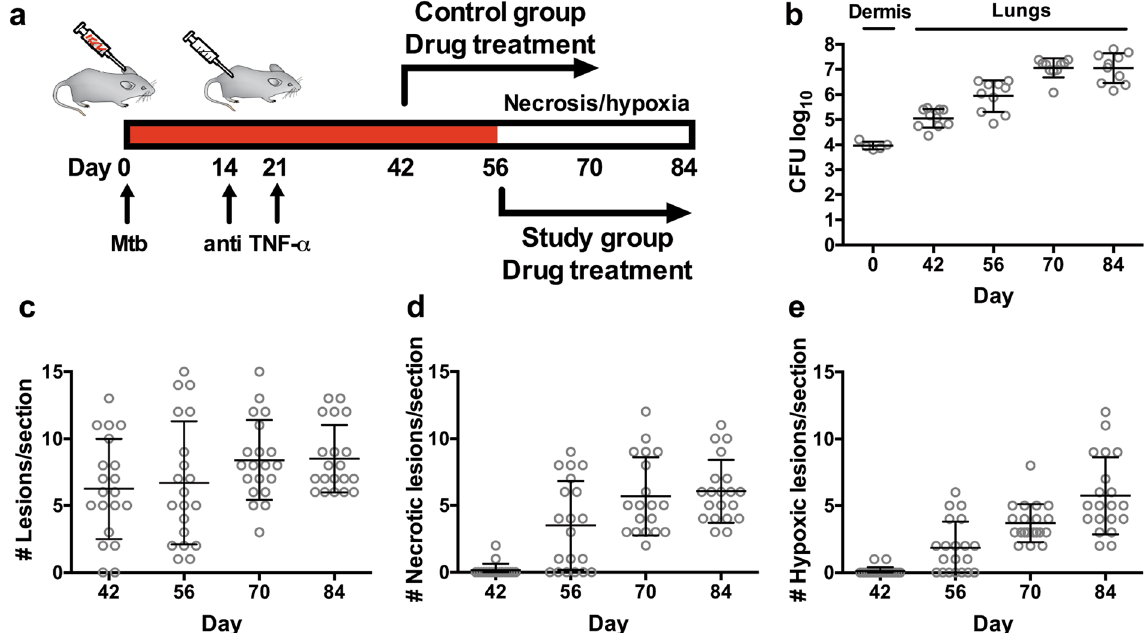
Figure 1. Temporal development of hypoxic necrotizing lung lesions in Nos2 − / − mice upon dermal M. tuberculosis infection. ( a ) Schematic representation of study design. ( b ) Infection dose (day 0) and bacterial burden in lungs at 42, 56, 70 and 84 days post-intradermal M. tuberculosis infection determined by plating serial dilutions of lung homogenates on agar. n = 10, representative of 2 independent experiments. ( c – e ) Histopathological evaluation of sections obtained from the entire left lung lobe of M. tuberculosis -infected Nos2 − / − mice at designated time points. Consecutive sections were stained with H&E to quantify lesions ( c ) and necrosis ( d ). Hypoxic lesions were identified by detection of pimonidazole adducts (Supplementary Fig. S1e), n = 5, representative of 3 independent experiments. Data are represented as means ± s.d. TNF- α , tumour necrosis factor alpha.